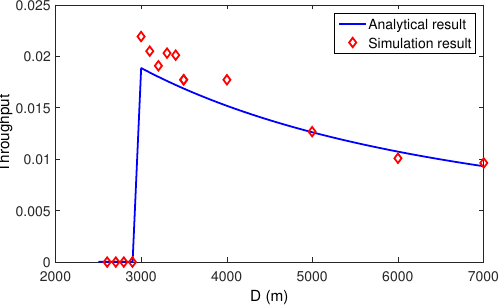
Figure 6. Impact of large-scale delay variation on throughput. The slot length in Slotted-FAMA should be slightly larger than the delay variation to reach the peak